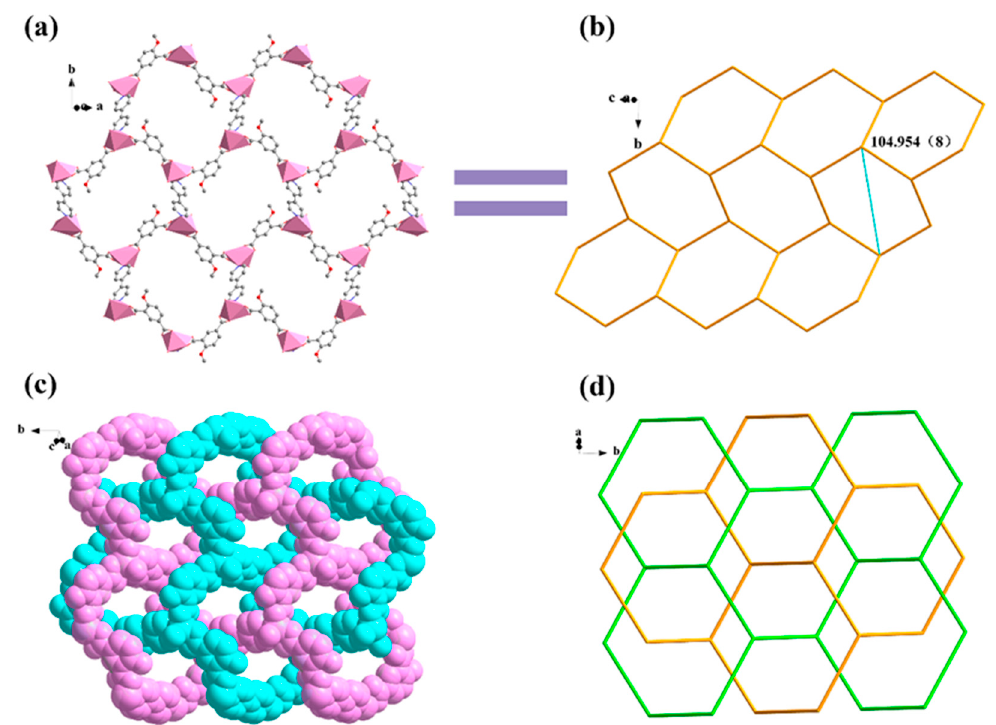
Figure 3. ( a ) The 2D layer of compound 2 , {[Zn(MIPA)(4,4 ′ -bipy) 0.5 (H 2 O)]·1.5H 2 O} n . The a, b and c represent a axis, b axis and c axis, respectively. ( b ) The corresponding node-and-linker diagram of the 2D layers in 2 . ( c ) The interpenetrating structure of 2 . ( d ) The corresponding node-and-linker diagram of structures interspersed between 2D layers in 2 .